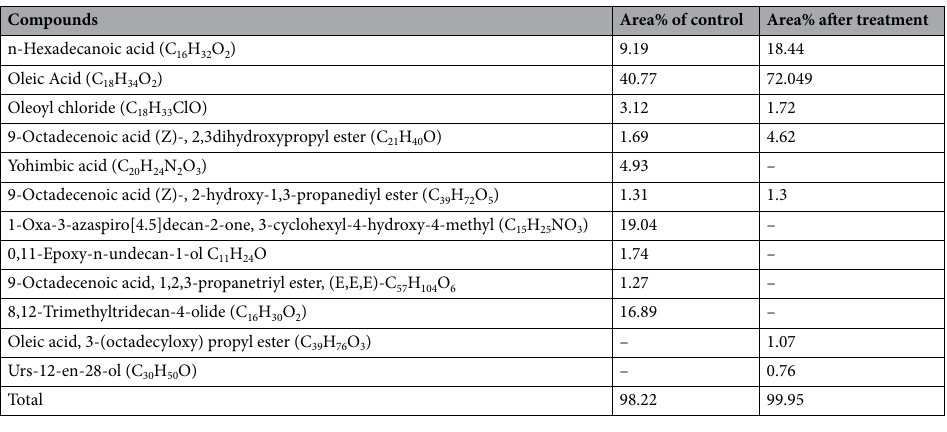
Table 2. GC–MS analysis of Fatty acids methyl ester (FAME) produced by S.obliquus (a) and under grown with Disperse orange 2RL Azo dye under hetrotrophic conditions with medium supplemented with 5% glucose at pH 11 and KNO 3 conc., 1 g/L